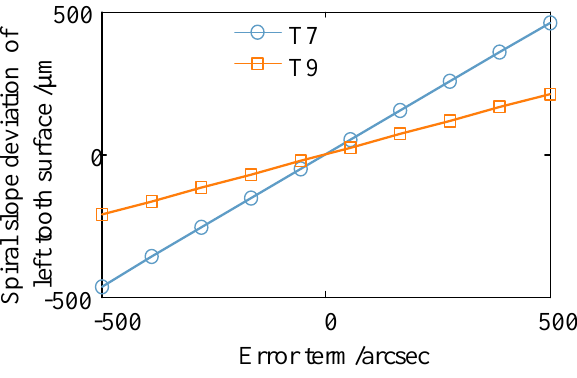
Figure 14. Relationship between spiral slope deviations, and T7 and T9.